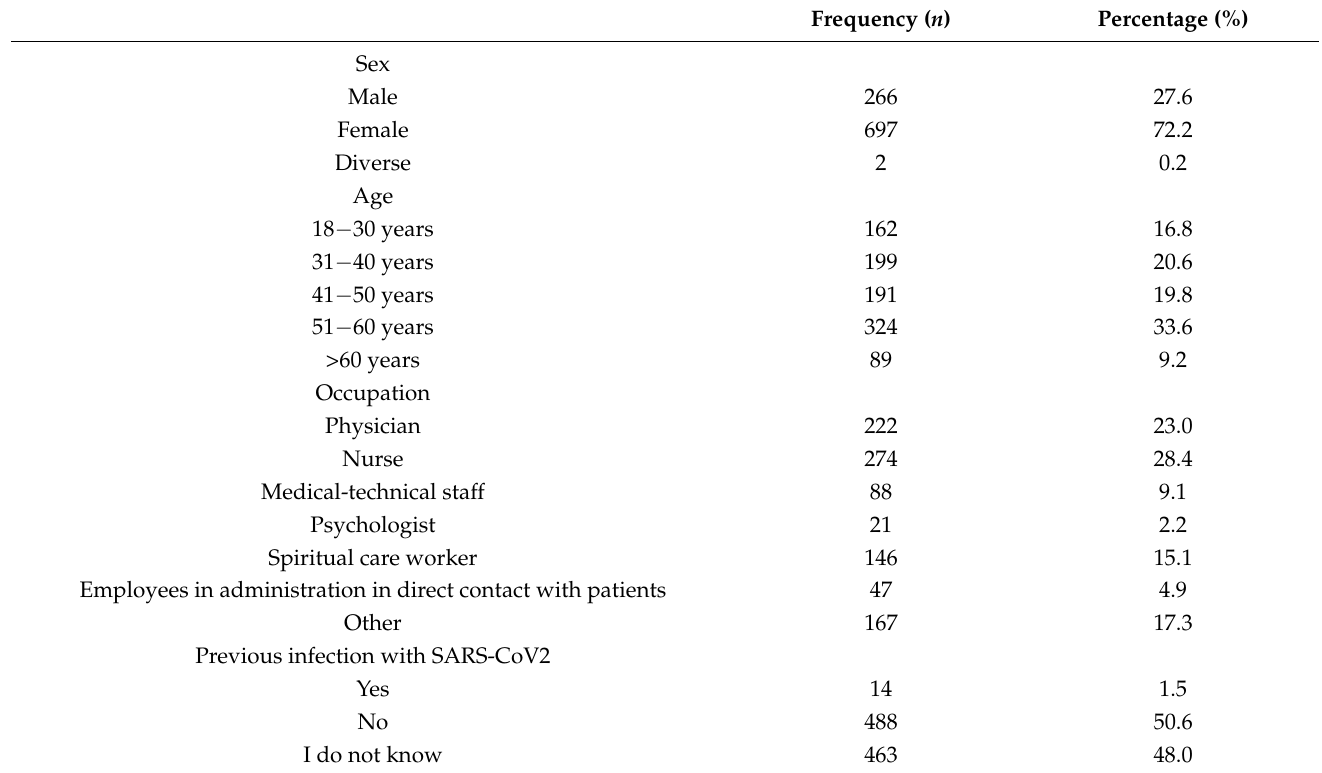
Table 1. Sample characteristics ( n = 965 healthcare